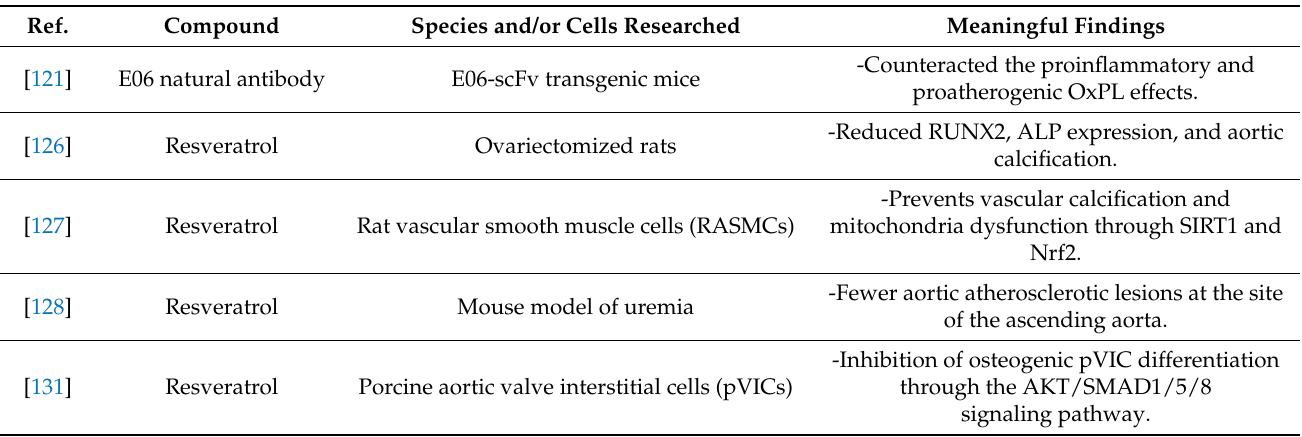
Table 3. Animal experimental studies of antioxidant compounds and other therapeutic options that target OS with potential in CAVD